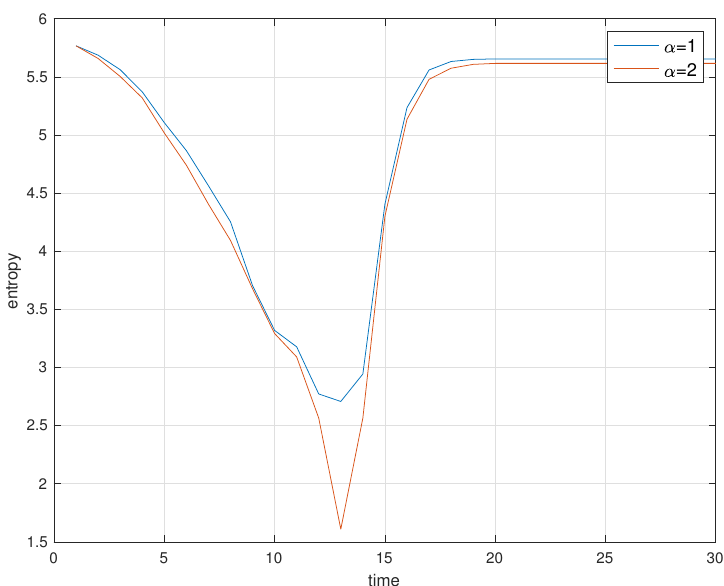
Figure 11. Space entropy H xy versus time t , for r = 20 and α = { 1,2 } ( N = 500, D = 0.05, n i = 50, δ = 0.1, p 1 = 0.1, p 2 = 0.9, p 3 = 0.7, p 4 = 0.05, p 5 = 0.02 and N h → ∞ ).